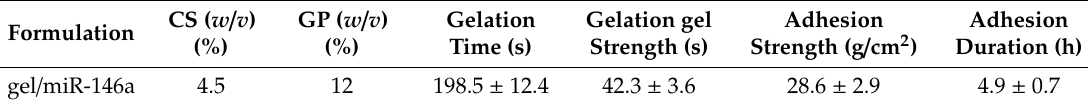
Figure 3. ( A ) Cumulative miR-146a curve of permeation in the nasal mucosa from the NPs/miR-146a, gel/miR-146a, and binary gel/NPs/miR-146a formulations. ( B ) Amount of miR-146a retained in the nasal mucosa after 48 h of application of the different formulations.